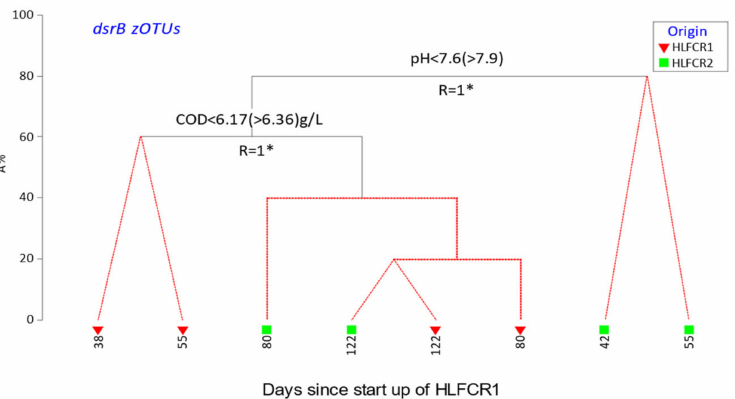
Figure 5. LINKTREE plot of clustering of sulfite reducing bacterial communities related to physico- chemical data. * significant ( p < 0.05).